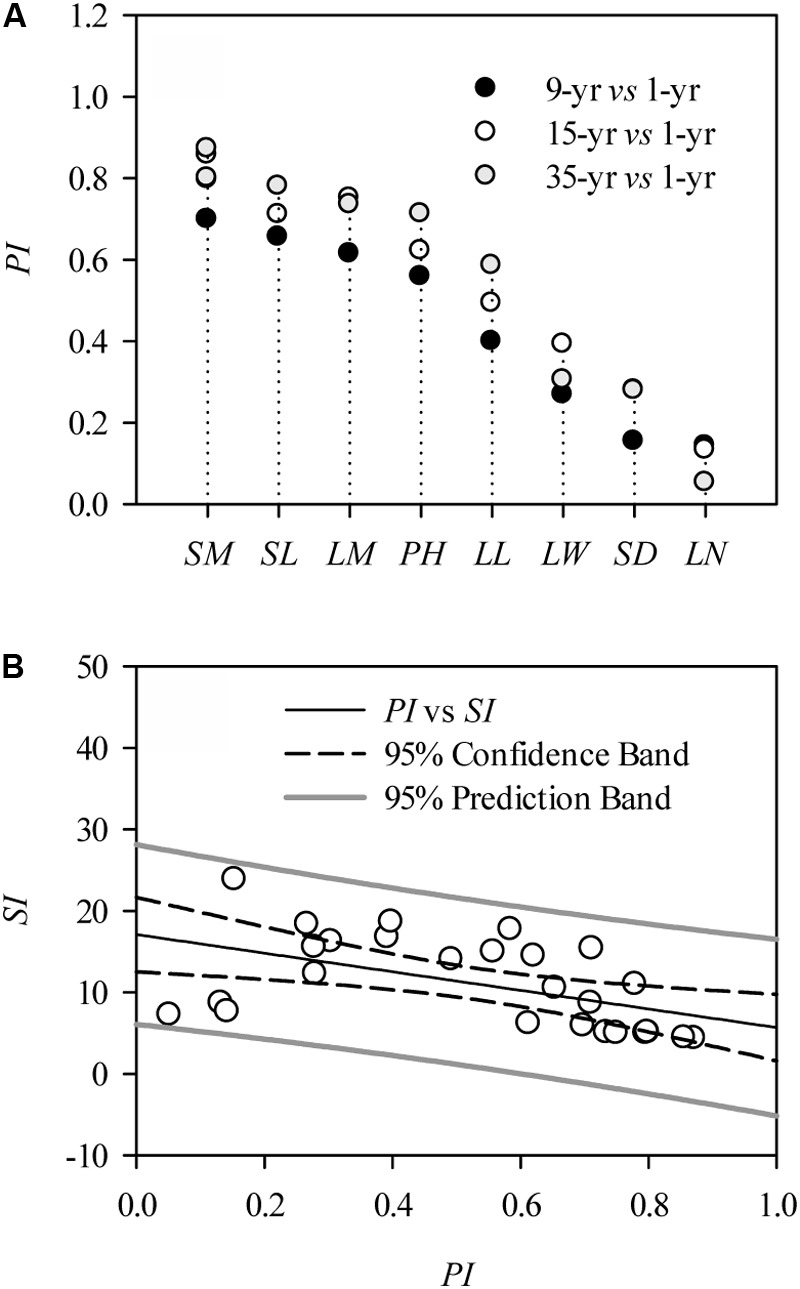
Morphological plasticity of Leymus chinensis in response to grazing exclusions. (A) Plasticity indexes (PI) of morphological traits, including: SM, stem mass; AM, aboveground mass; SL, stem length; LM, leaf mass; PH, plant height; LL, leaf length; LW, leaf width; SD, stem diameter; and LN, leaf number. (B) Correlation between PI and stability indexes (SI) of plant morphological traits of L. chinensis in response to grazing exclusion; the relation between them is fitted by a Pearson correlation (r = –0.52, P < 0.01).